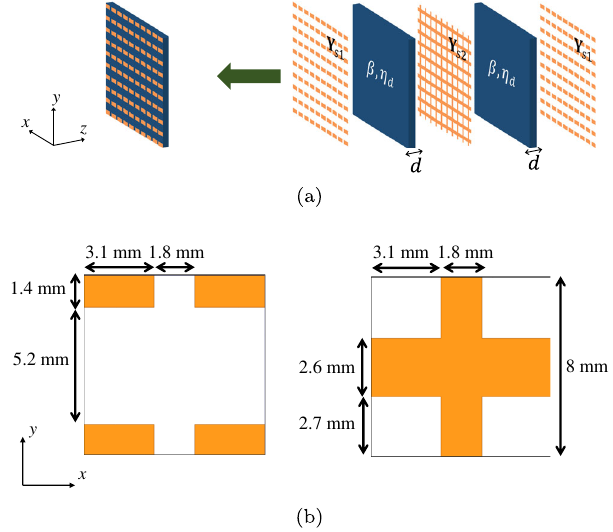
FIG. 2. (a) Topology of the QWP. The design uses Rogers ¼ 3 . 55 and tan δ ¼ 0 . 0027 ) with a thickness 4003C substrates ( ε r of d ¼ 1 . 524 mm. (b) Metallic patterns on the outer (left) and inner (right) sheets of the designed QWP.